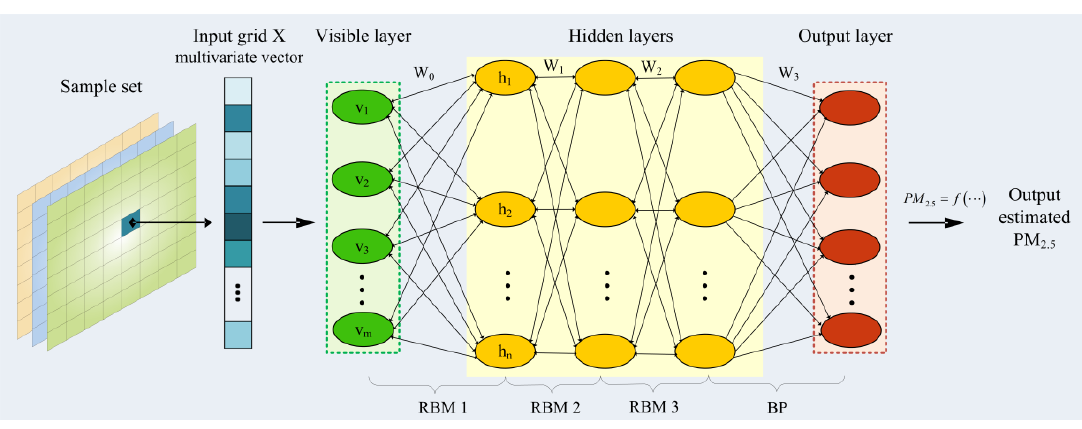
2.5 . “DBN” means deep belief